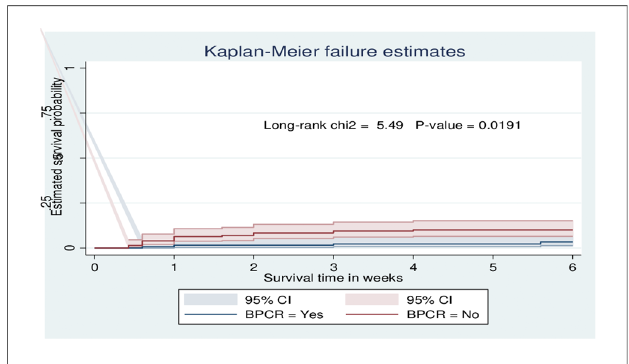
FIGURE 8 Kaplan-Meier curve showing the survival probability of developing puerperal sepsis among postnatal women based on